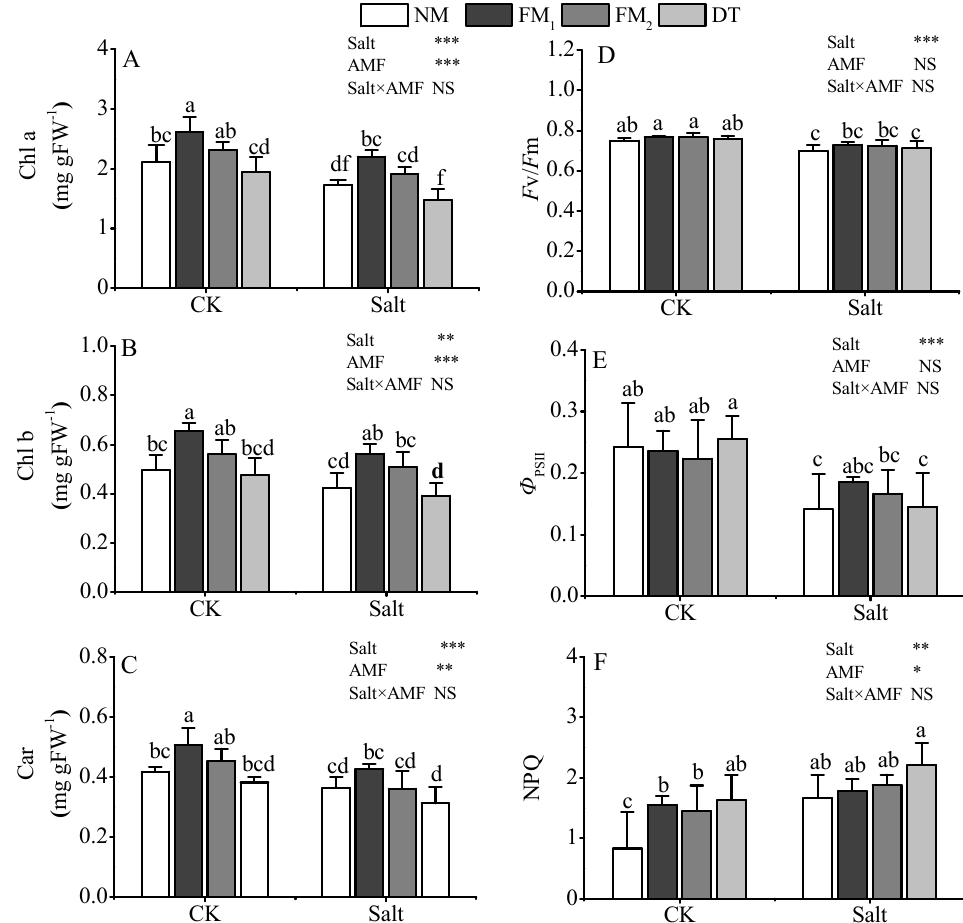
Figure 3. Effects of salt treatments and AMF inoculation on the photosynthetic pigments ( A – C ) and chlorophyll fluorescence ( D – F ) of Z. serrata seedlings leaves. Vertical bars indicate the standard error of the mean ( n = 4). Different lowercase letters indicate significant differences between the three AMF under control and salt stress at the 0.05 significance level; NS not significant, * p < 0.05, ** p < 0.01, *** p < 0.001.